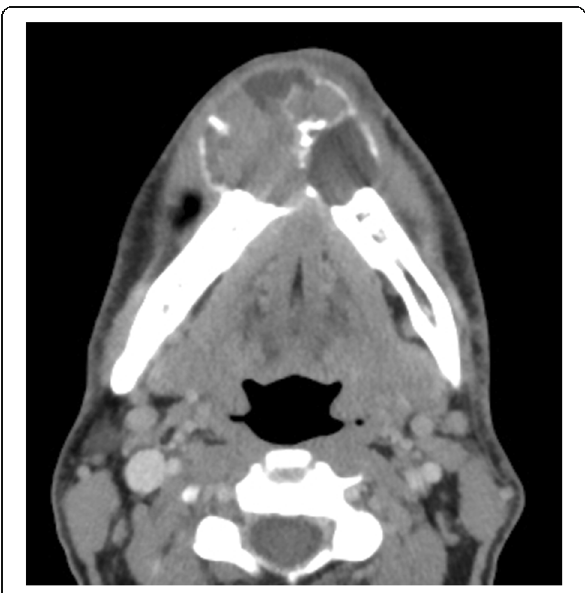
Fig. 7. Ameloblastoma. Axial CT image shows a multilocular expansile lesion arising from the mandibular body